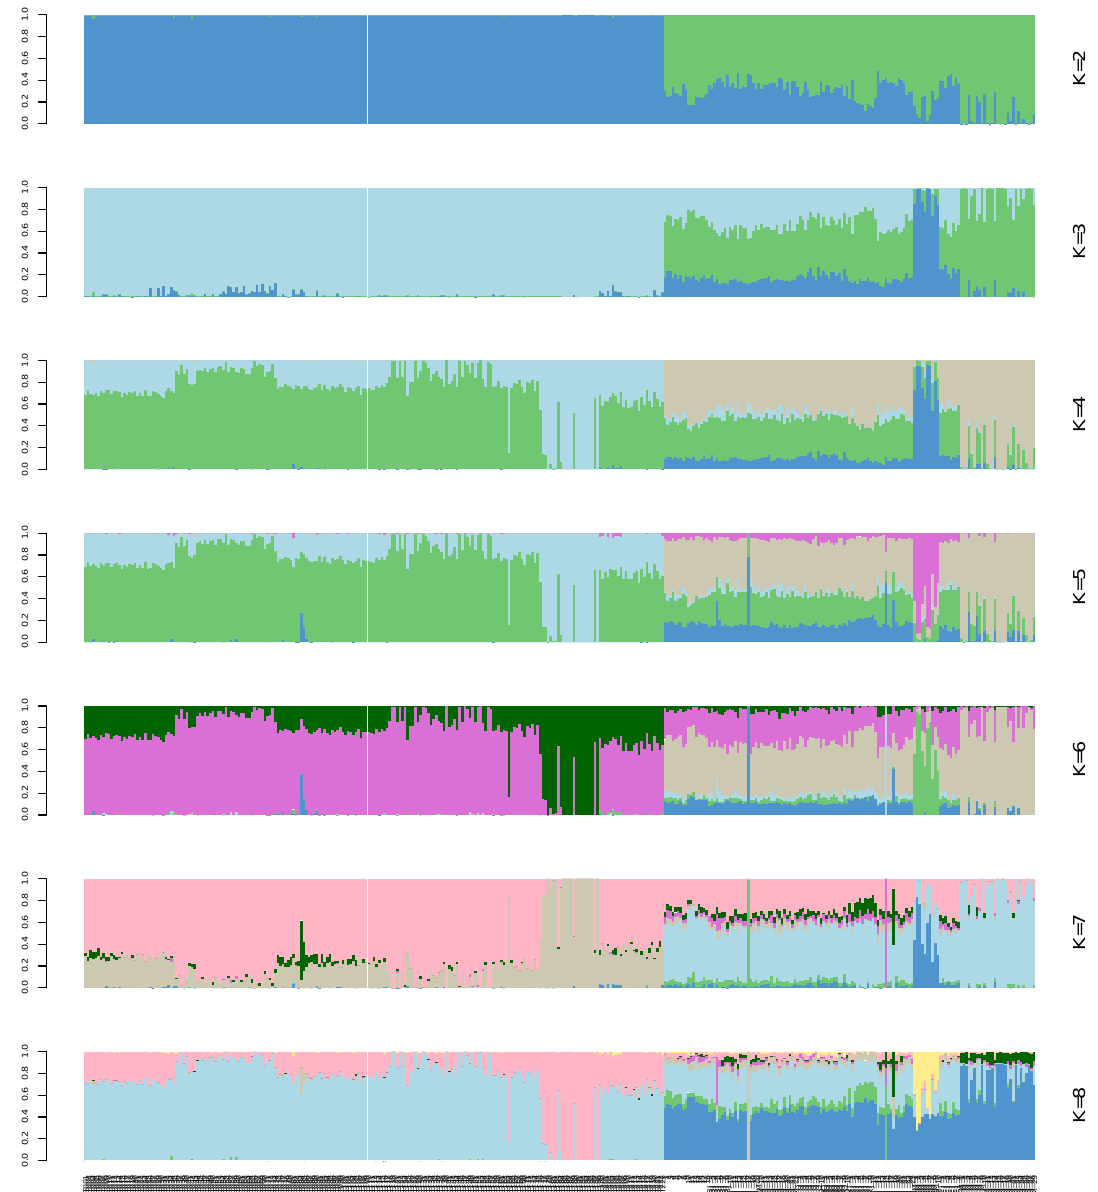
Figure 3. Population structure analysis of 366 Bactrian camels. The abscissa is each sample, and the ordinate represents the number of ancestors from 2 to